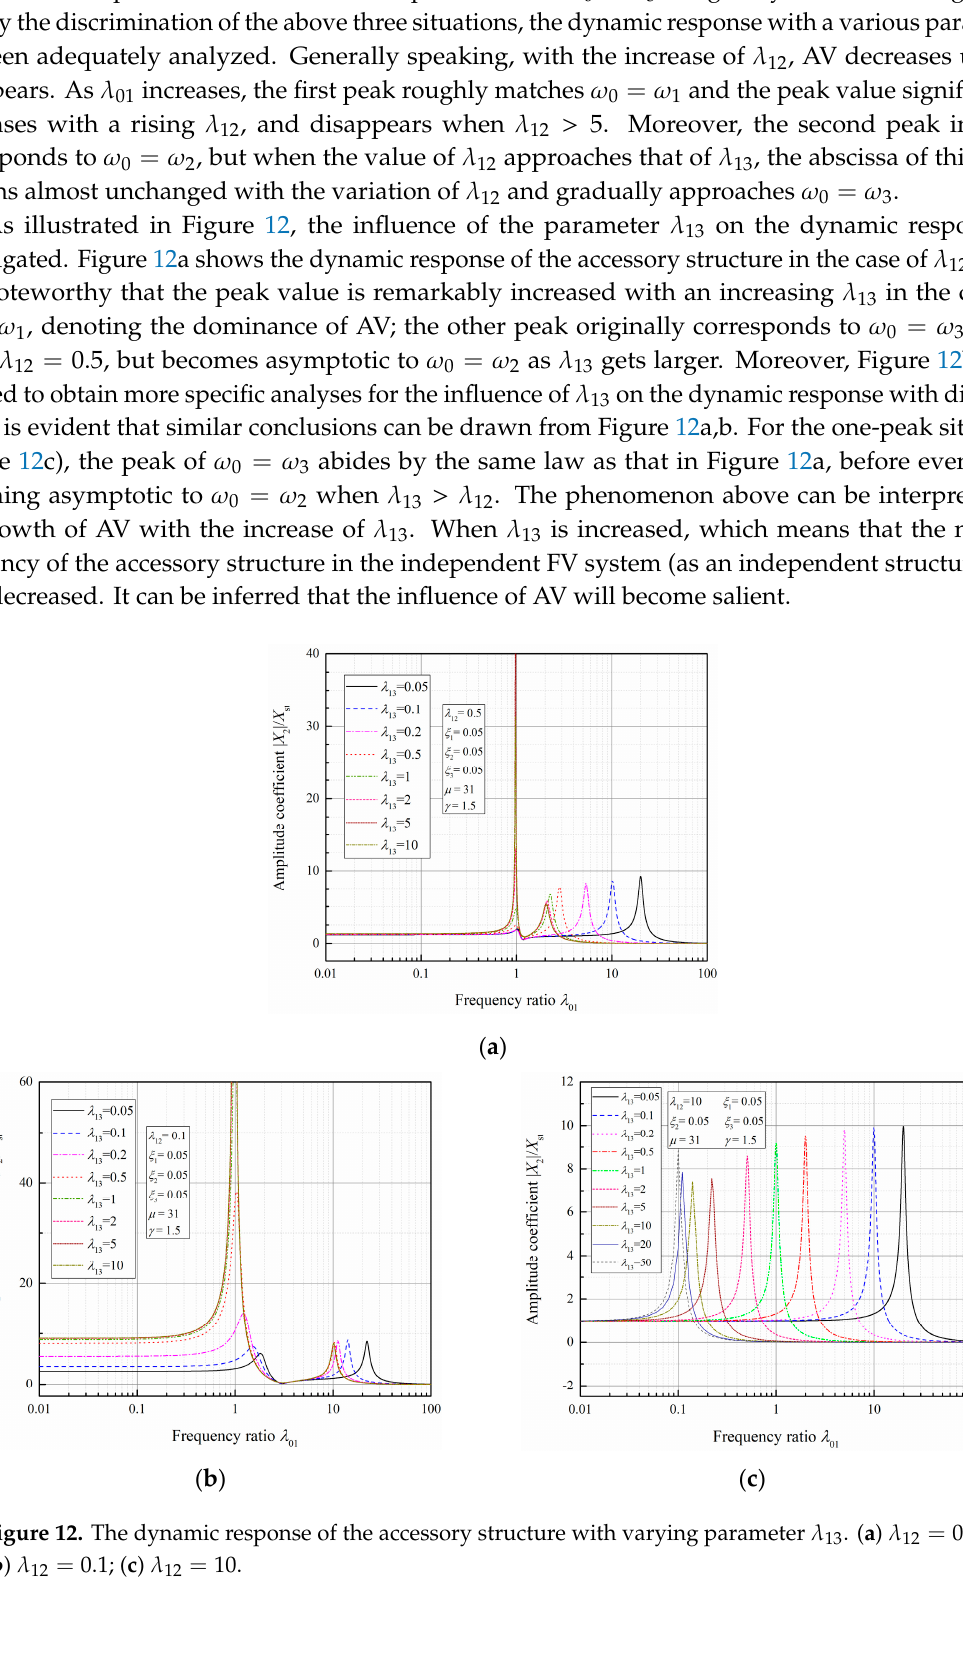
λ . ( a ) . 0 5 λ = ; 13 12